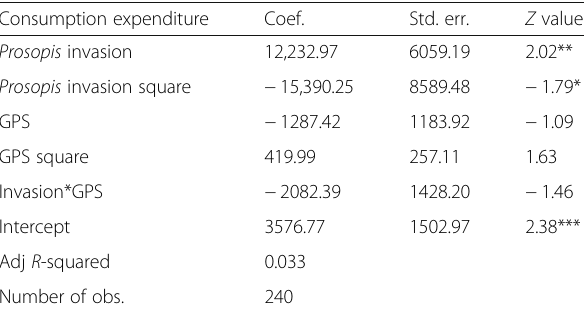
Table 9 Estimated dose-response function for household per capita consumption expenditure Consumption